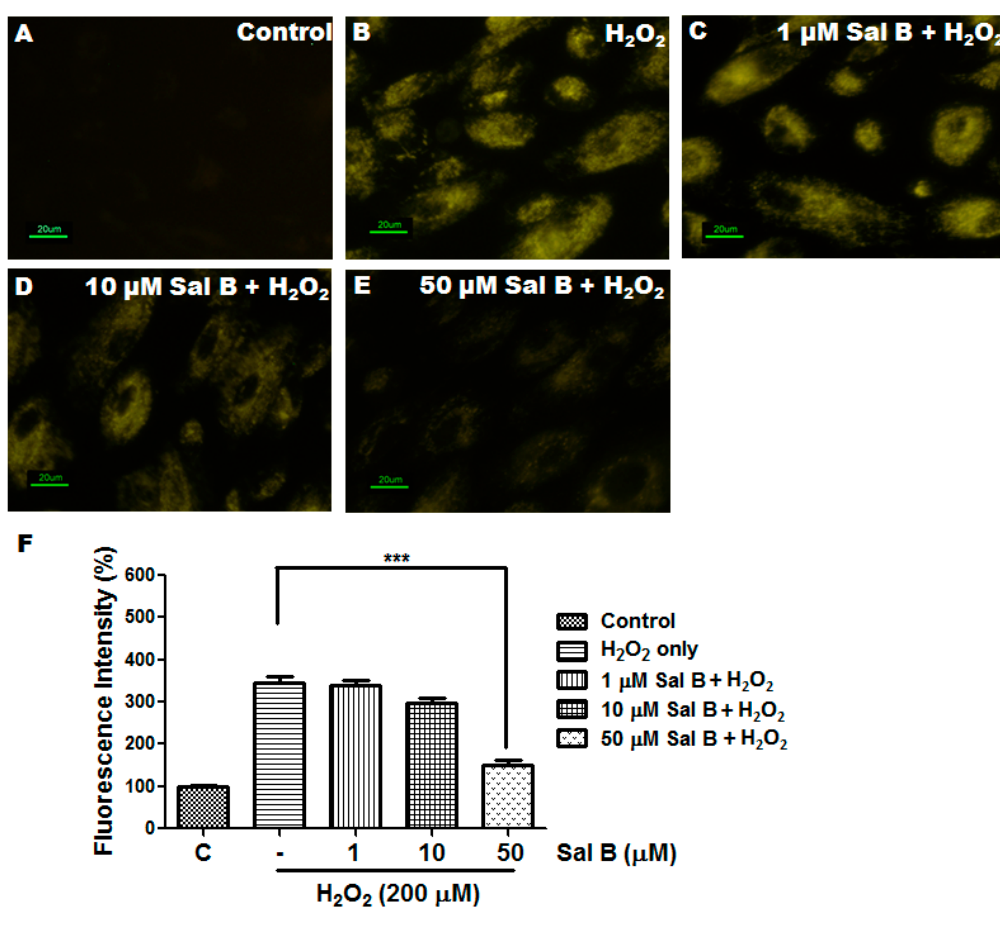
Figure 3. Sal B reduces reactive oxygen species (ROS) production in H 2 O 2 -treated RPE cells. RPE cells as a control with no treatment ( A ); and pretreatment without ( B ); or with 1 ( C ); 10 ( D ); and 50 μ M ( E ) Sal B for 24 h, followed by 200 μ M H 2 O 2 treatment for 30 min. Fluorescence was detected using the probe CellROX orange reagent for all groups; and ( F ) fluorescence intensity quantified and represented as the mean ± SEM of three independent experiments, *** p < 0.001 compared with the H 2 O 2 -only